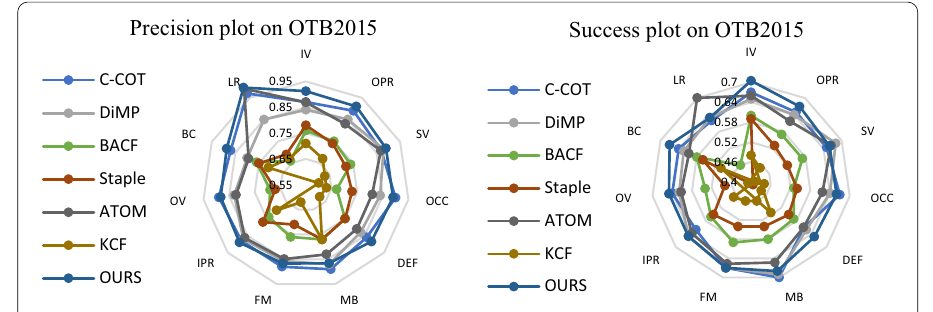
Fig. 6 Radar plot of precision and success based on tracking results on the OTB2015 dataset in 11 challenging